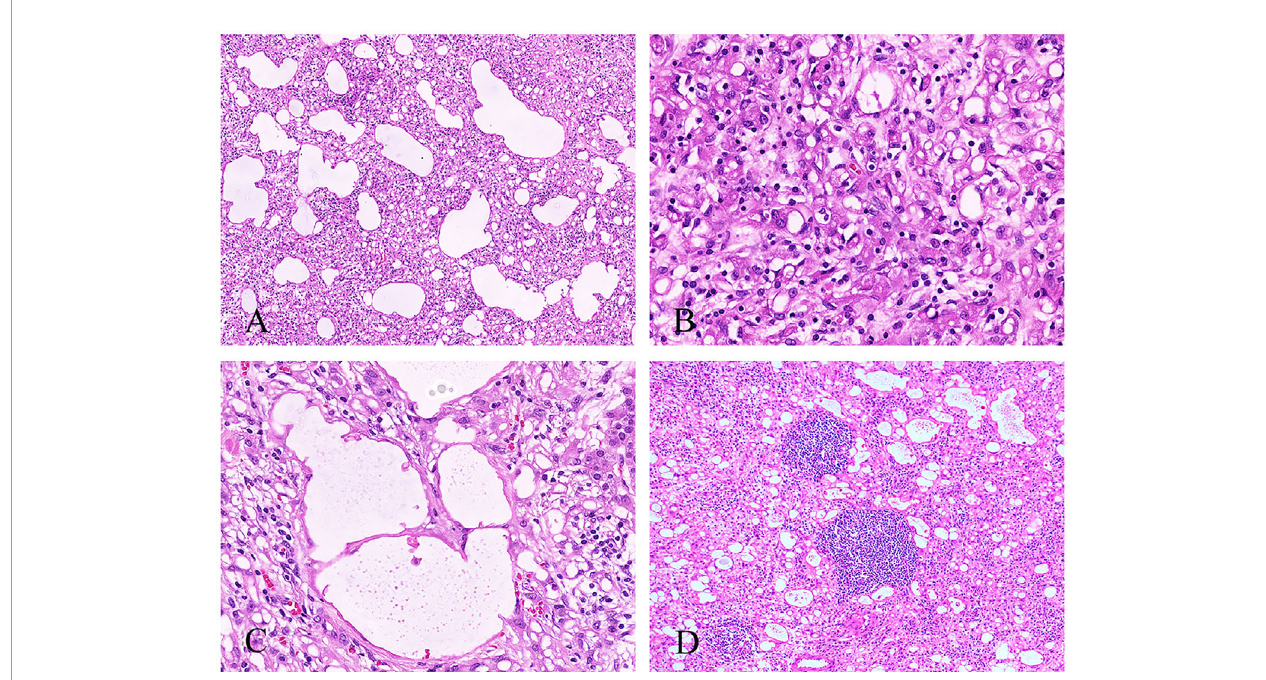
FIGURE 2 | Histological features of the adrenal AT. (A) The angiomatoid pattern of tumor composed of anastomosing, variably sized tubules lined by fl attened or cuboidal cells (100×). (B) The solid pattern of tumor composed of epithelioid cells with eosinophilic cytoplasm, and signet-ring-like cells can be seen (400×). (C) Thread-like bridging strands were found (400×). (D) Some lymphocytes were in fi ltrated and aggregated in the stroma